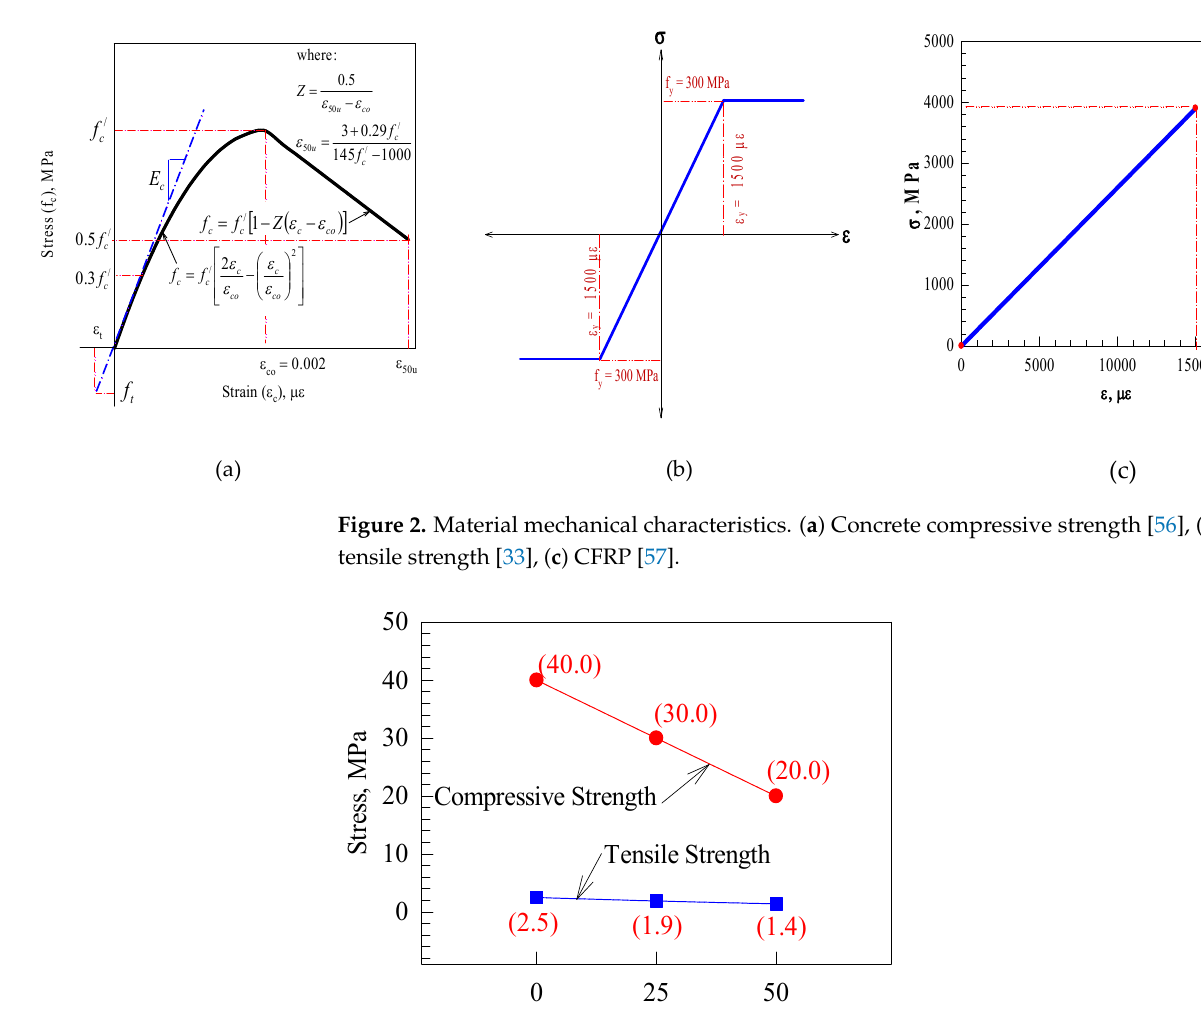
Figure 3. Concrete strength degradation.